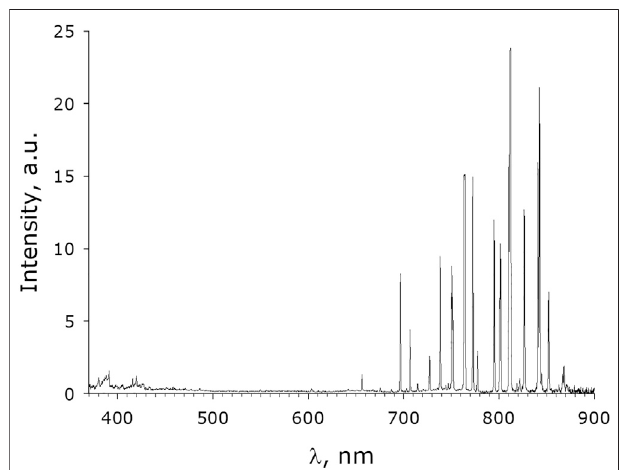
FIGURE 3 | Optical emission spectrum of the plasma jet, observed throughthequartzwalloftheexperimentalcell,measuredwhentheplasmajet was immersed in